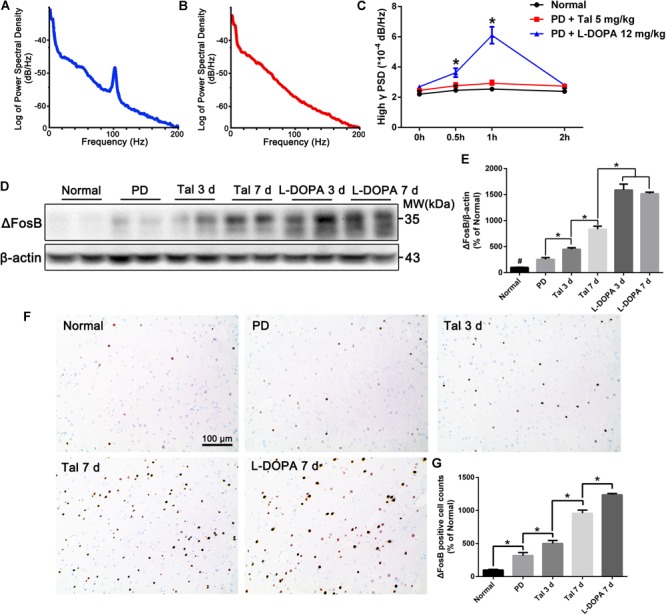
Acute or sub-chronic administration of Taltirelin relieved bradykinesia without inducing dyskinesia. (A,B) Power spectral distribution of local field potential (LFP) after treatment of L-DOPA (12 mg/kg, with benserazide 6 mg/kg) or Taltirelin (5 mg/kg, i.p.). (C) Power of high γ oscillation changed with time (32 LFP data in MI and DLS of two intact rats and 96 LFP records in six lesioned rats). (D,E) Western blot analysis of ΔFosB in the DA-denervated striatum of each group (normal, PD, Tal 5 mg/kg or L-DOPA 12 mg/kg treated for 3 or 7 days). N = 3. (F) Immunostaining of ΔFosB of lesioned striatum. (G) Counts of ΔFosB-positive cells in each group. N = 3. #p < 0.01 vs. intact or other groups; ∗p < 0.05; ∗∗
p < 0.01. N = 3. Error bars represent SEM.